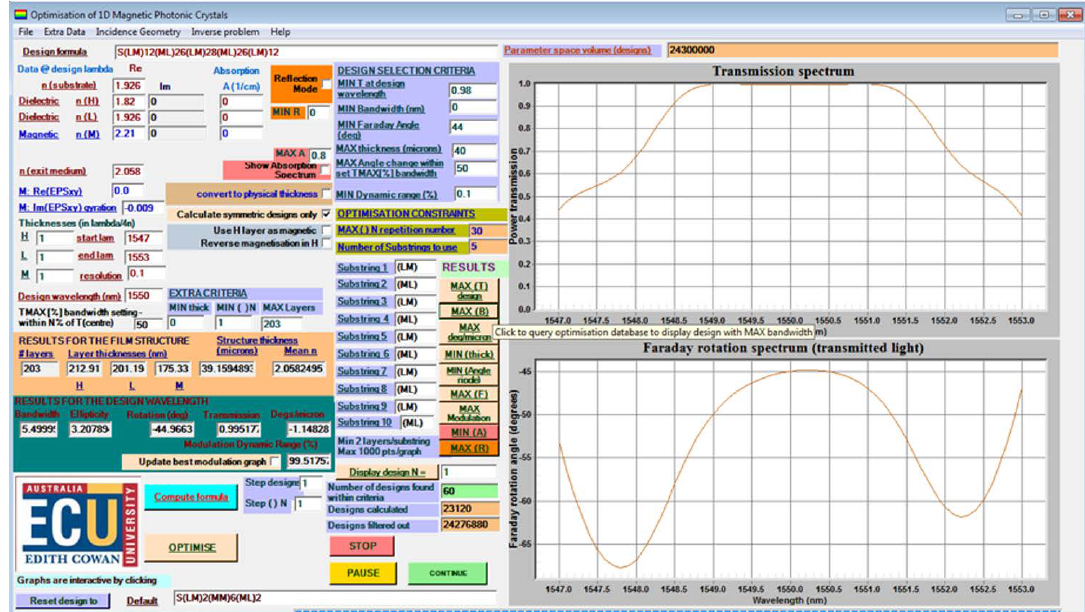
Figure 4. Optimized “flat-top” high-performance MPC design reproduced by running the MPC optimization algorithm, using checkbox “Calculate symmetric designs only” for speeding up calculations. The exact four-defect MPC design reported in [11] (Figure 3b of [11]) is shown after selecting the design with maximum spectral response bandwidth from the 60 possible MPC designs found to be within the optimization criteria and constrains, as shown.